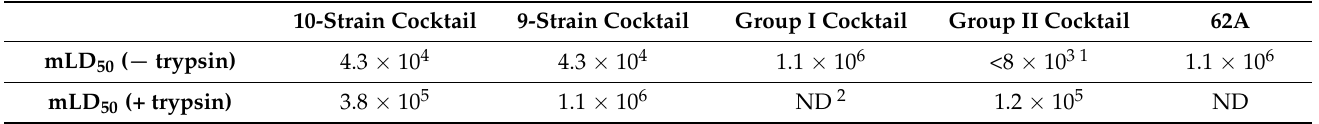
Table 3. BoNT activity of cultures grown at 30 ◦ C for 4 days, determined by mouse